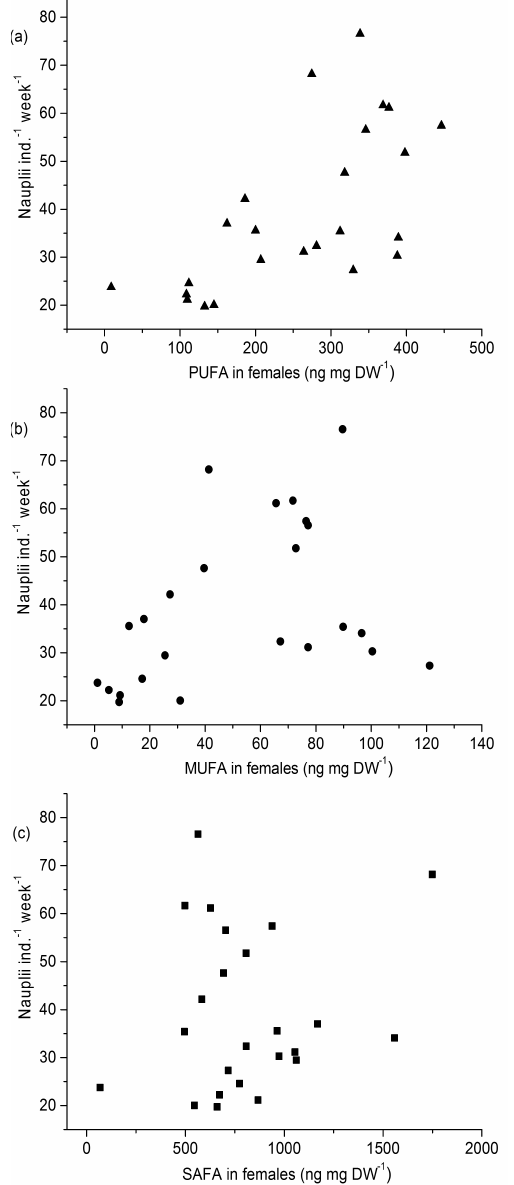
Figure 4. Relationship between nauplii production and female (a) PUFA, (b) MUFA, and (c) SAFA content.